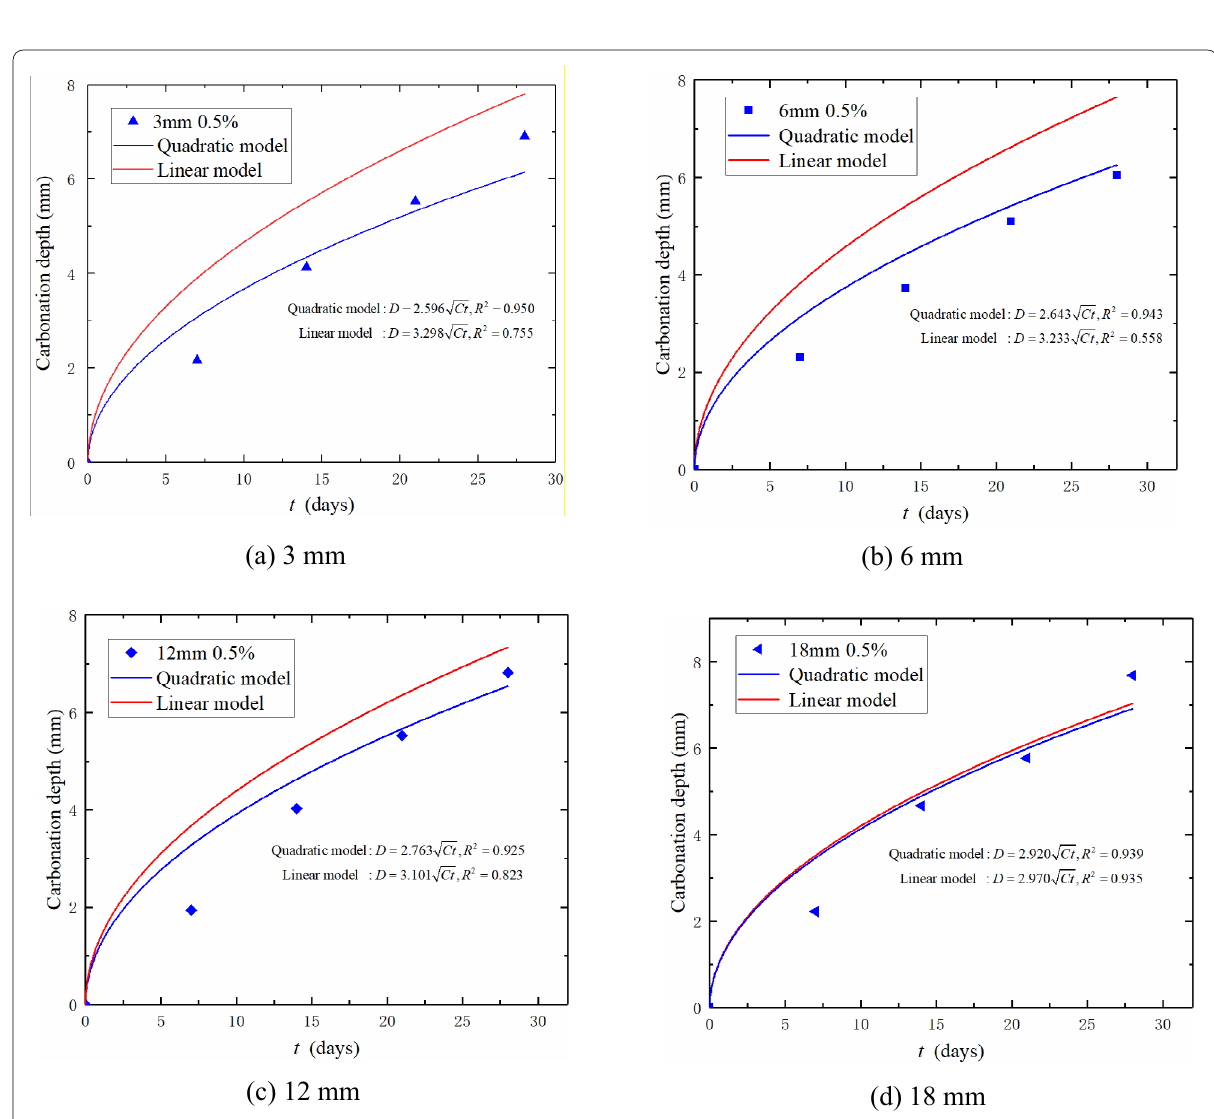
Fig. 5 Carbonation depth predictions of PVA fiber concrete with a fiber content of 0.5% and different fiber lengths from the linear and quadratic